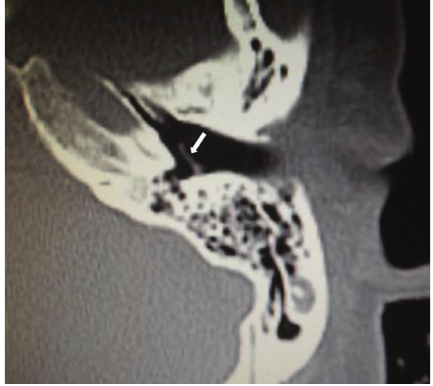
Figure 3: Axial computed tomography scan of the left temporal bone showed thickening of the tympanic membrane with a normal middle ear and mastoid cavity (arrow: tympanic